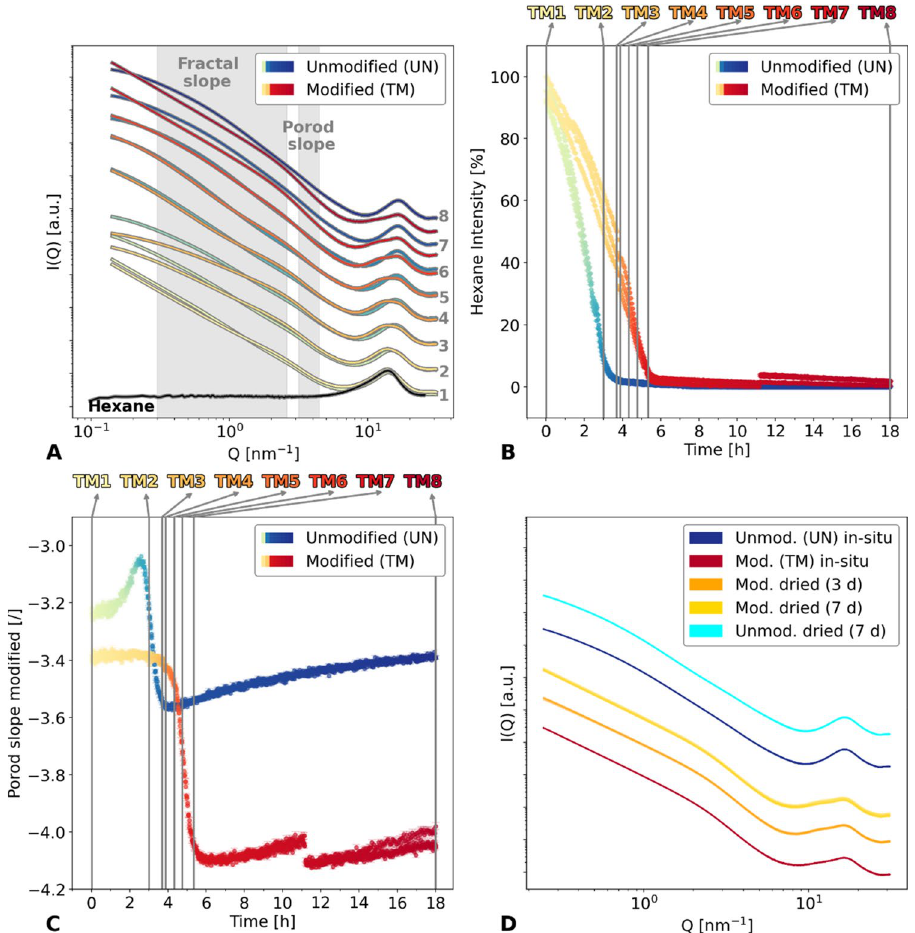
Figure 4. ( A ) Small-angle X-ray scattering (SAXS) diagram with Y-offset of specific points of interest (UN1 to UN8 and TM1 to TM8) are colour-coded to the appropriate time. These points of interest have been chosen according to noticeable changes of the fractal slope. ( B ) The hexane content in the UN (green/blue) and TM (yellow/red) samples over time have been derived from the decoupling of the peak in the region 13.73 nm −1 . A split into three lines can be observed especially for TM, as the samples were investigated at three different heights. Additionally, specific points of interest are overlaid for TM1 to TM8 (grey). ( C ) The Porod slope is corrected for hexane in the material for UN (green/blue) and TM (yellow/red) samples over time, and superimposed with specific points of interest (grey, TM1 to TM8). ( D ) Different modified and unmodified samples in the dried state are compared by means of X-ray scattering. The abbreviation “TM/UN dried” refers to samples of the same batch but dried prior to the synchrotron